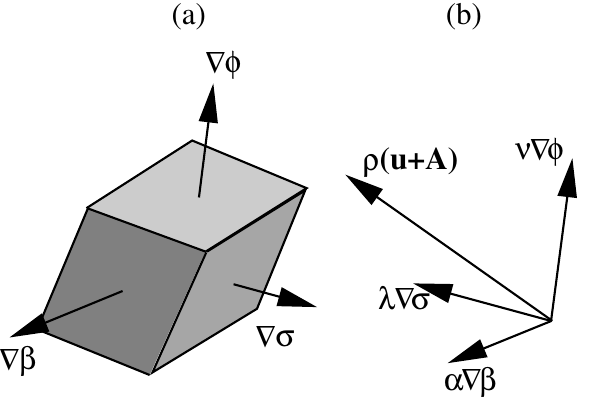
Figure 1. ( a ) Small fluid parcel with surfaces of constant φ , β , and σ . ( b ) The gradients ∇ φ , ∇ σ , and ∇ β are adjusted by scalars ν , λ , and α to yield the local momentum density p = ν ∇ φ + λ ∇ σ + α ∇ β